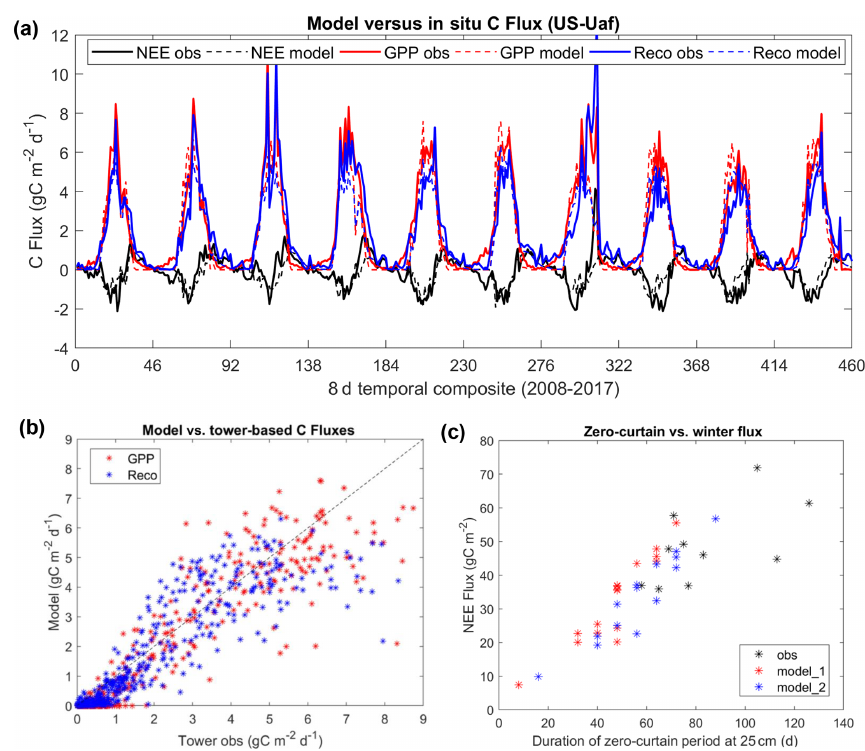
Figure 5. Comparisons of model-simulated carbon fluxes with tower-based estimates (a, b) , and the relations of total NEE fluxes to the zero- curtain duration at 25cm soil depth (c) . There was a significant correlation ( R = 0 . 6, p < 0 . 1) between the zero-curtain period derived from in situ soil moisture data and the total NEE fluxes during this period. The terms “model_1” and “model_2” indicate the model simulations using different soil saturation levels, with “model_2” using a slightly higher (120%) saturation level than “model_1”.